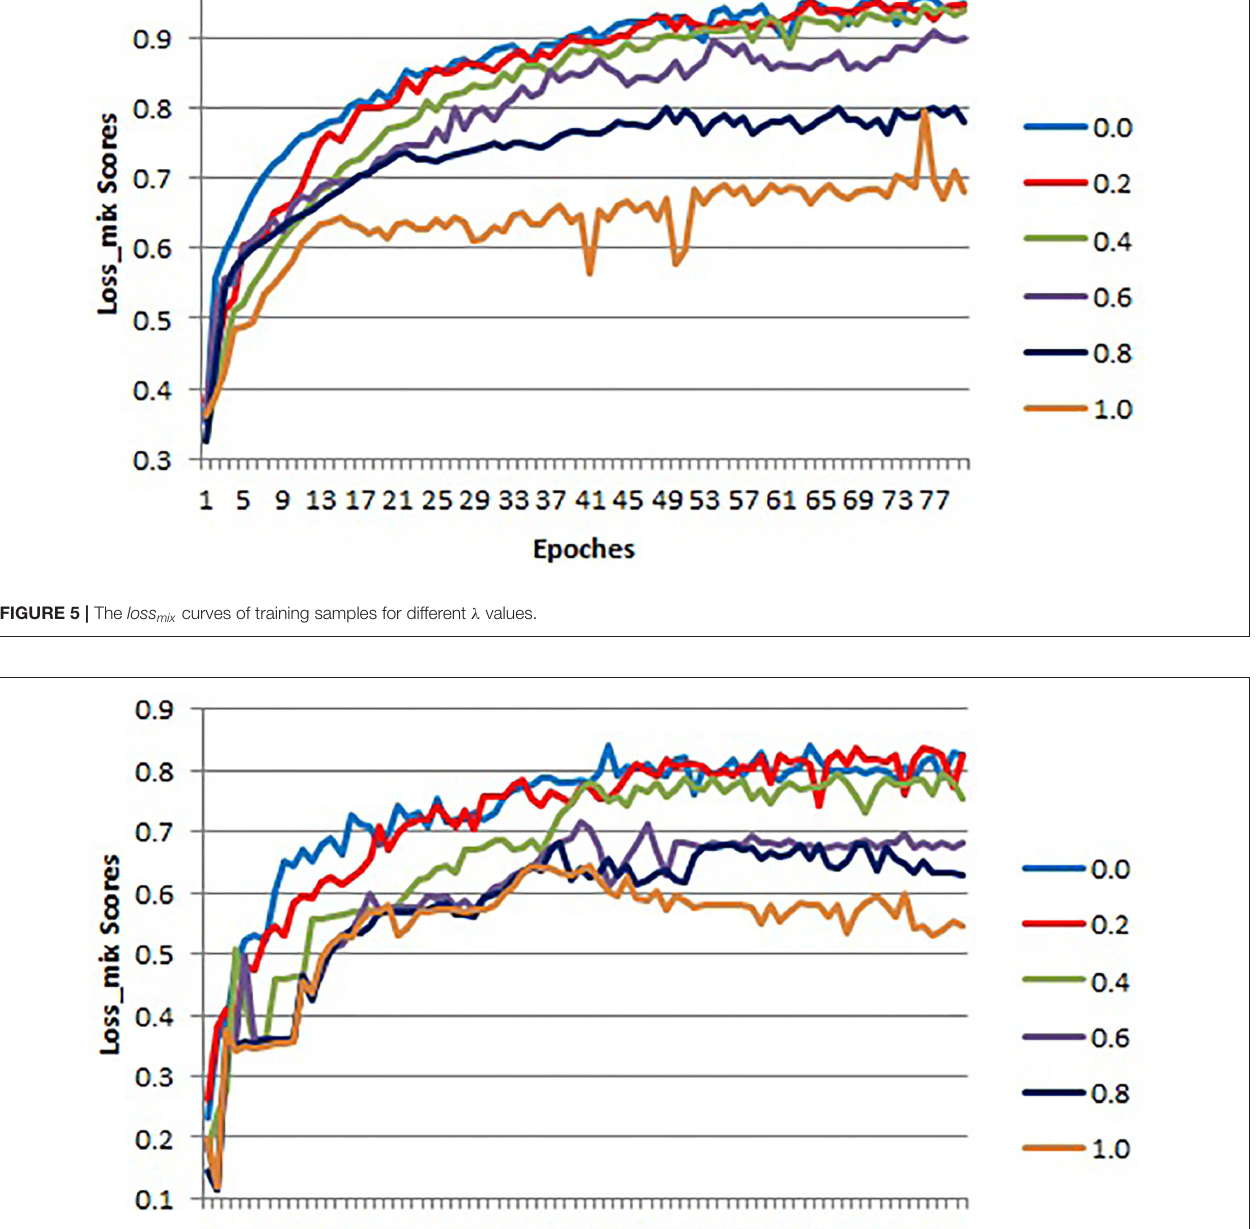
study proves useful in mitigating the shortage of labeled samples of penumbra targets, with two dozens of labeled samples proving sufficient to auxiliary train a highly efficient segmentation